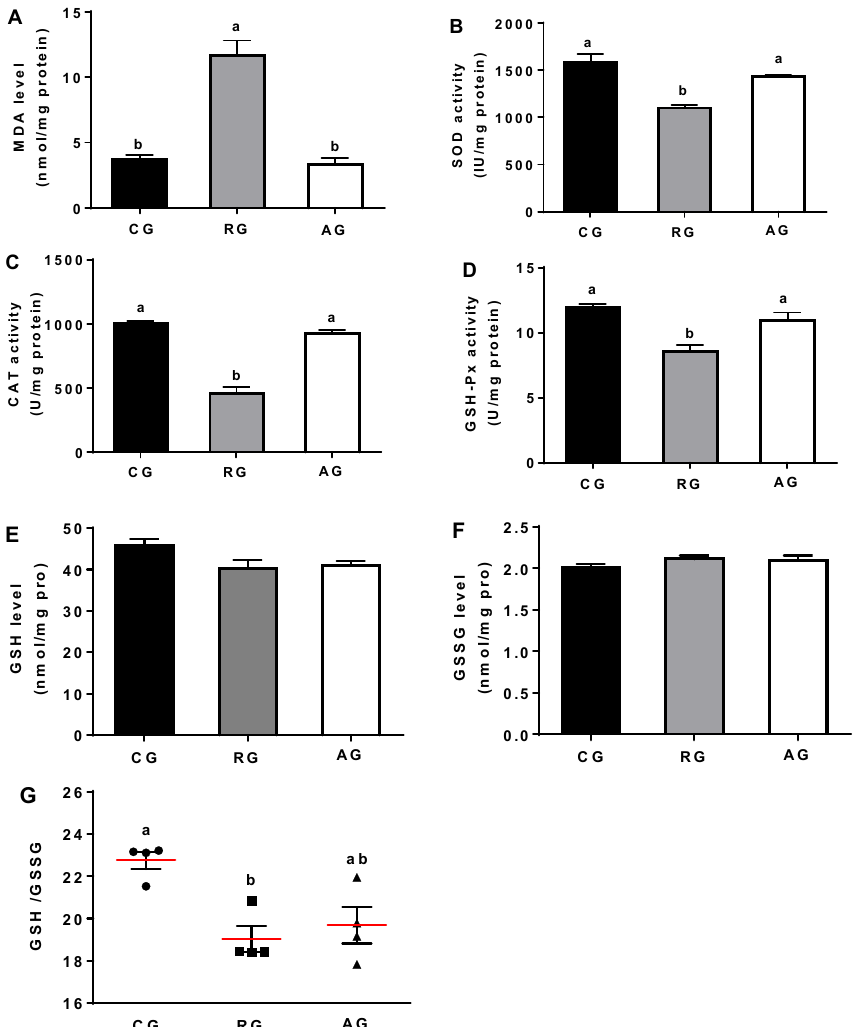
Figure 2. Effects of diet and arginine on the antioxidant capability in ovaries of ewes. ( A ): MDA level in ovary; ( B ): SOD activity in ovary; ( C ): CAT activity in ovary; ( D ): GSH-Px activity; ( E ): GSH level in ovary; ( F ): GSSH level in ovary; ( G ): GSH/GSSG. Abbreviations: CG, control group; RG, restriction group; AG, Arg group; MDA, malondialdehyde; SOD, superoxide dismutase; CAT, catalase; GSH-Px, glutathione peroxidase; GSH, glutathione; GSSG, oxidized glutathione. Values are m eans ± SE (n = 4). “ ▲ ,▪,•” means each measurement data. Columns with different super- scripts differ significantly among any groups ( p < 0.05).